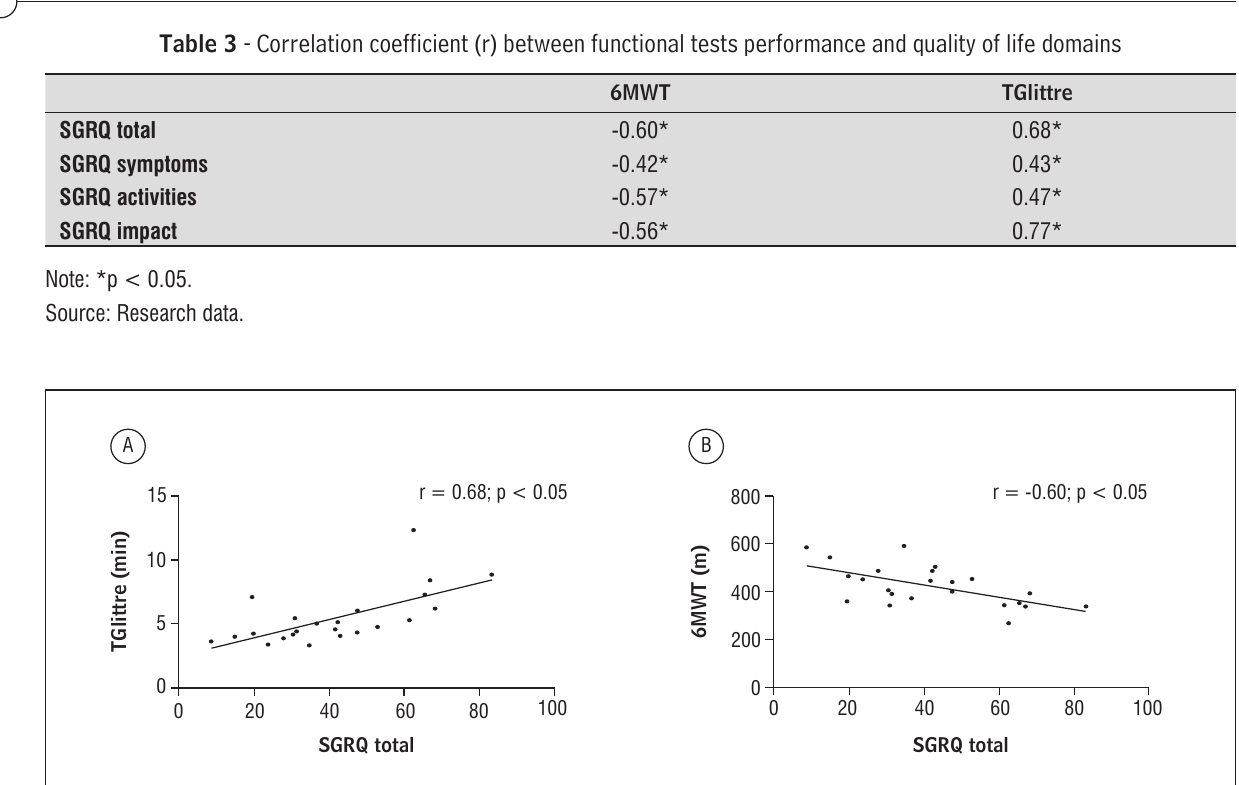
Figure 1 - A) Correlation between the SGRQ score and the time spent in Glittre ADL-test (TGlittre). (B) Correlation between the SGRQ score and six minute walking test distance (6MWT) Source: Research data.